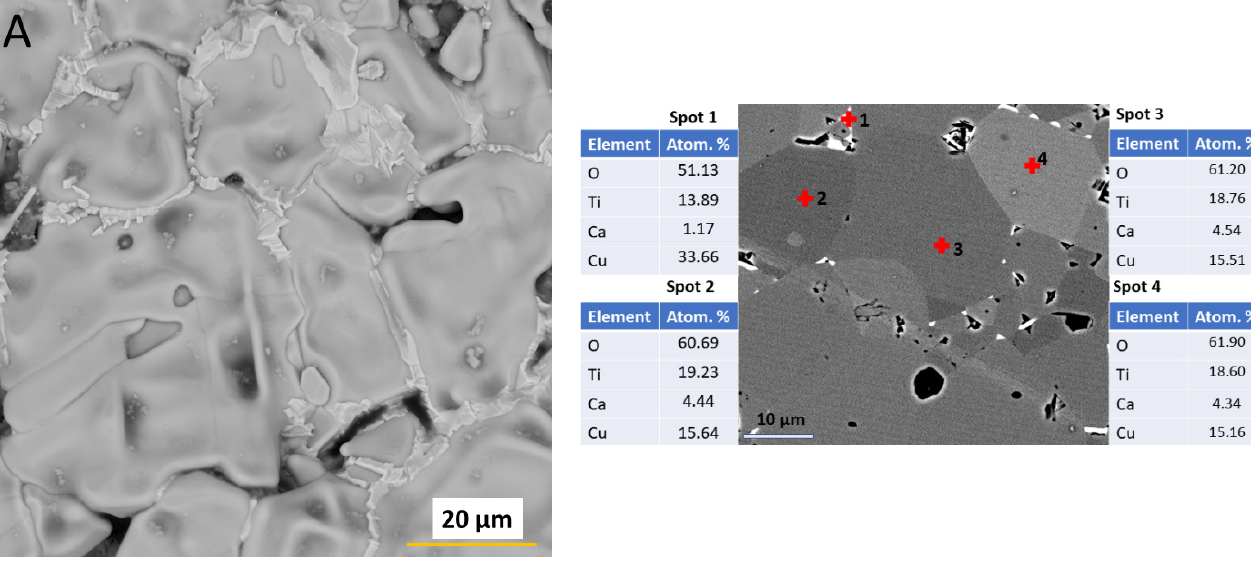
Figure 8. SEM-BSE micrograph of machined, but not polished surface ( A ) HPF sample F (1050 °C, 120 min, fast cooling 100 °C/min); ( B ) HPF sample J (1050 °C, 120 min, slow cooling 10 °C/min). Figure 9 displays the mercury intrusion porosimetry (MIP) curves for the SPS sample A, which exhibited bimodal grain distribution in the as-sintered conditions. Considering the results and the change of porosity due to annealing, we can conclude that besides the above-mentioned separation of phases, annealing in air at about 1000 °C leads also to pores coalescence. The sample annealed at 900 °C presents a high peak at about 0.05 µm, while the sample annealed at 1000 °C presents two smaller peaks, one just below 0.1 µm and the other at about 0.7 µm, which is even smaller. This indicates that a process of pore coarsening occurred during annealing since the as-sintered sample shows a peak at about 0.01 µm. Pore coarsening is disadvantageous for improving the dielectric behavior. The small secondary peak around 50 µm corresponds to less-frequent coarse pores. Additionally, samples with bimodal grain size also tend towards bimodal porosity. It is possible that the annealing temperatures of 900 and 1000 °C were too high, since CCTO starts to sinter at about 850 °C. However, annealing at 850 °C was not sufficient to